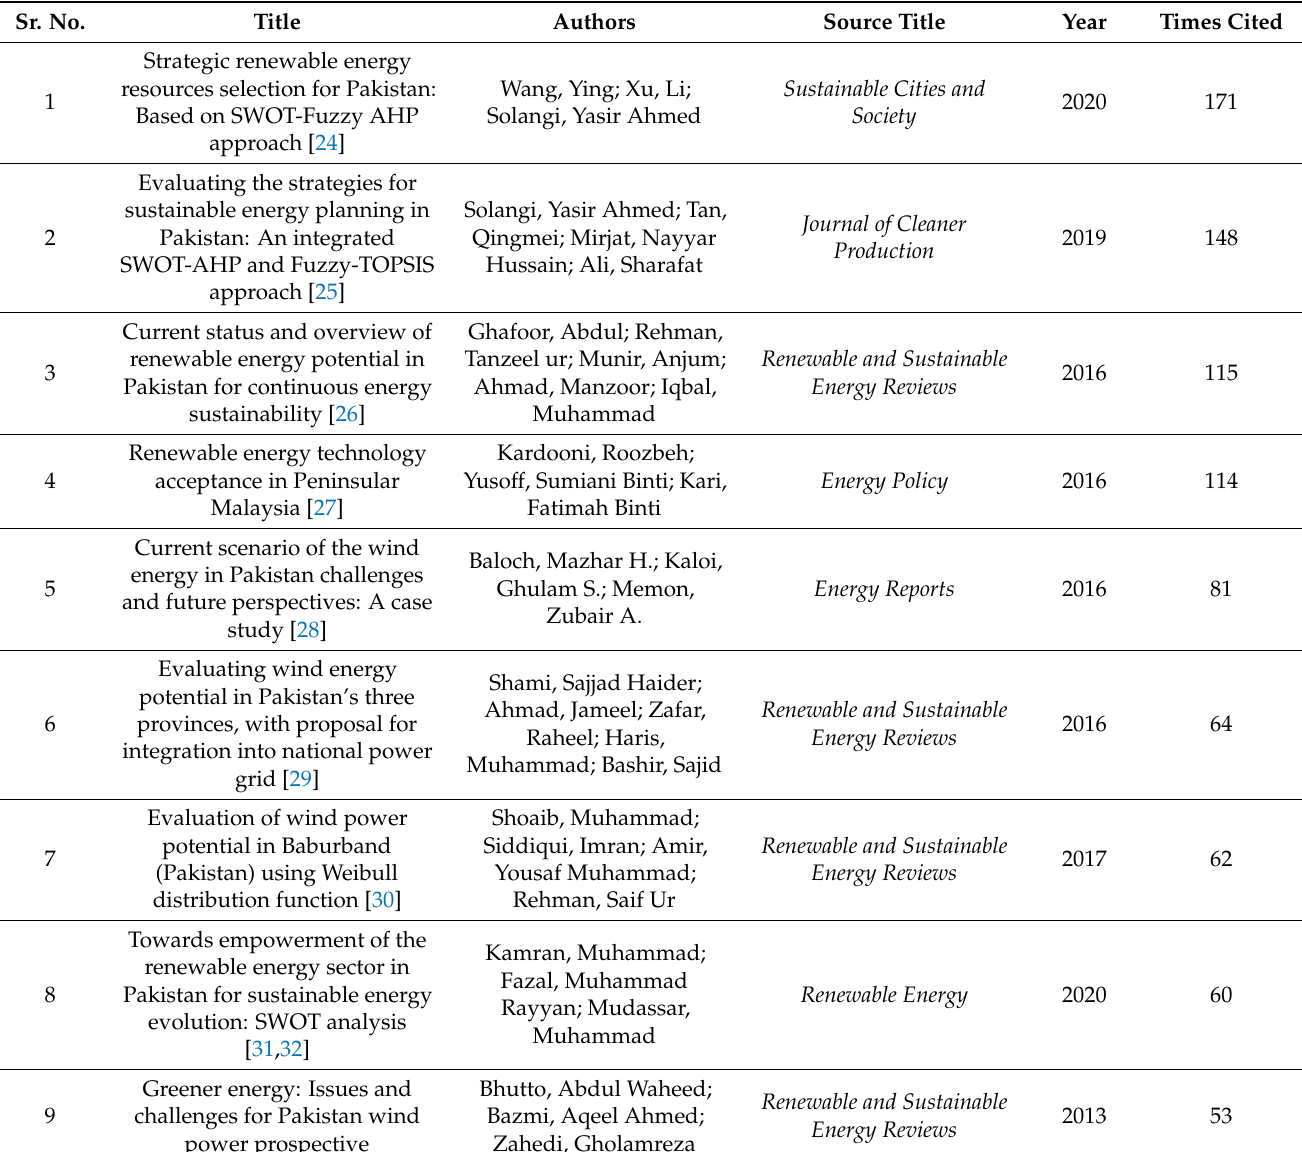
Table 2. Details of records with more than 50